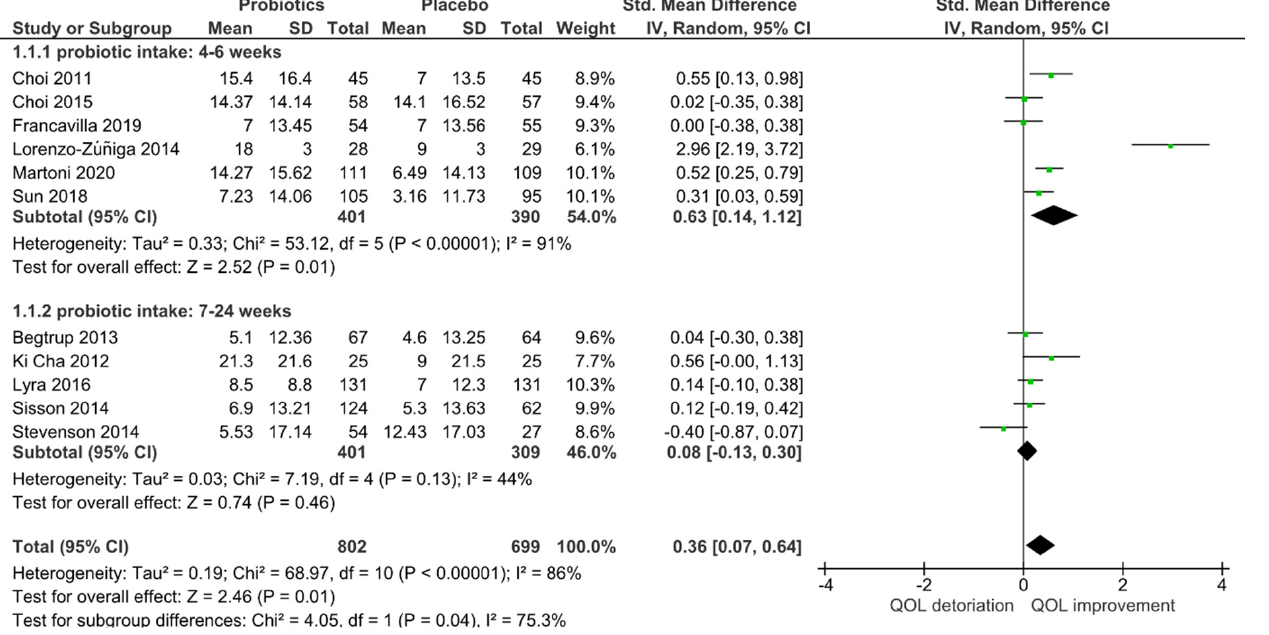
Figure 5. Effect of intake period on quality of life (QoL) of randomized controlled trials in IBS receiving either probiotics or placebo treatment.